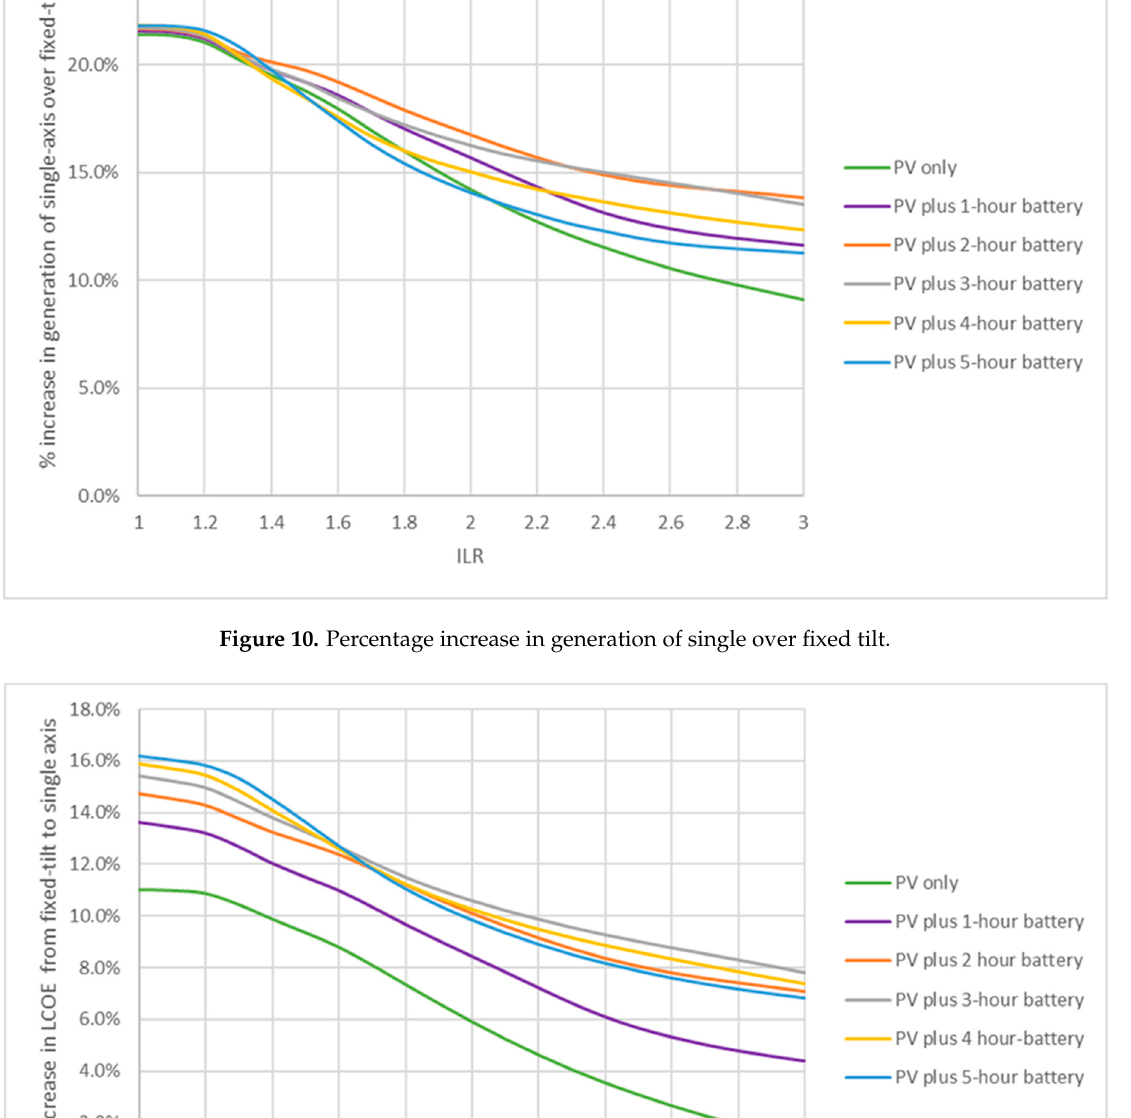
Figure 9. Comparison of % marginal clipping loss between fixed and single axis tracking.